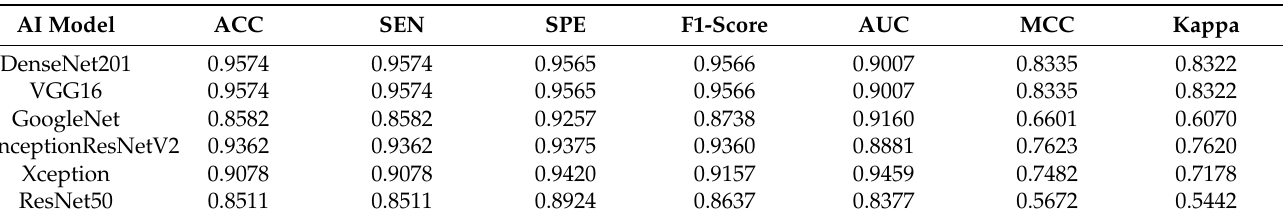
Table 4. Binary approach classification evaluation results of the individual pre-trained deep learning models using the testing set of the INbreast dataset.